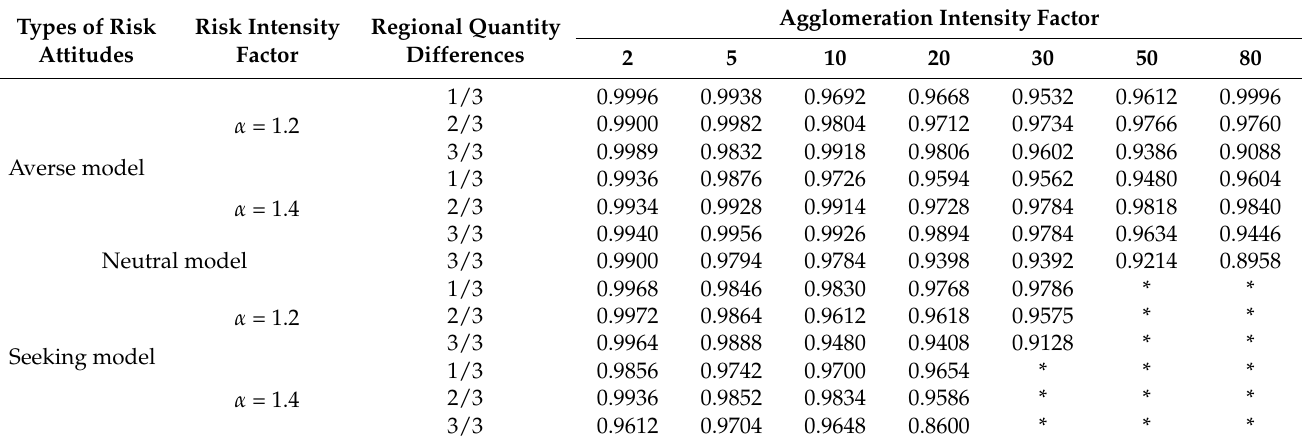
Table 2. Comparison of the R 2